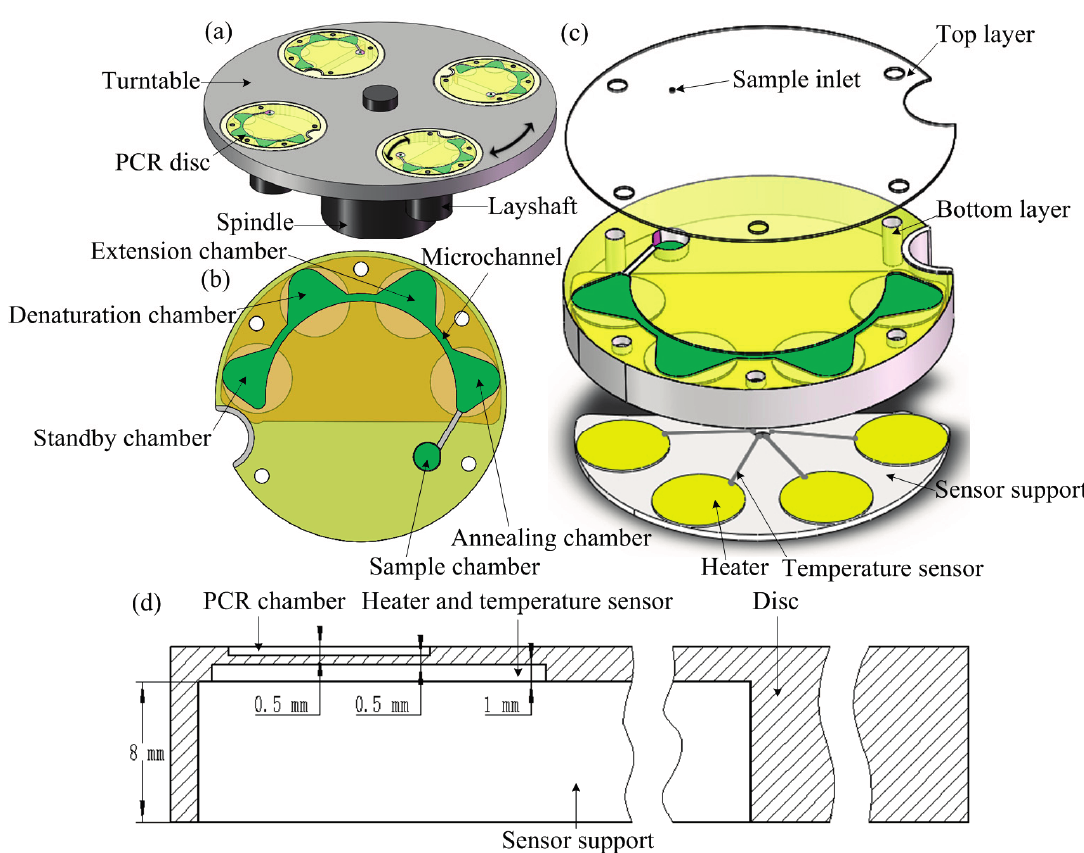
Figure 2. ( a ) Schematic illustration of the fluid control unit consisting of a double-shaft turntable and a centrifugal-based PCR disc; ( b ) Top view of the disc comprising the sample chamber and four reaction chambers; ( c ) Enlarged view of the disc consisting of two layers; ( d ) Section view of the